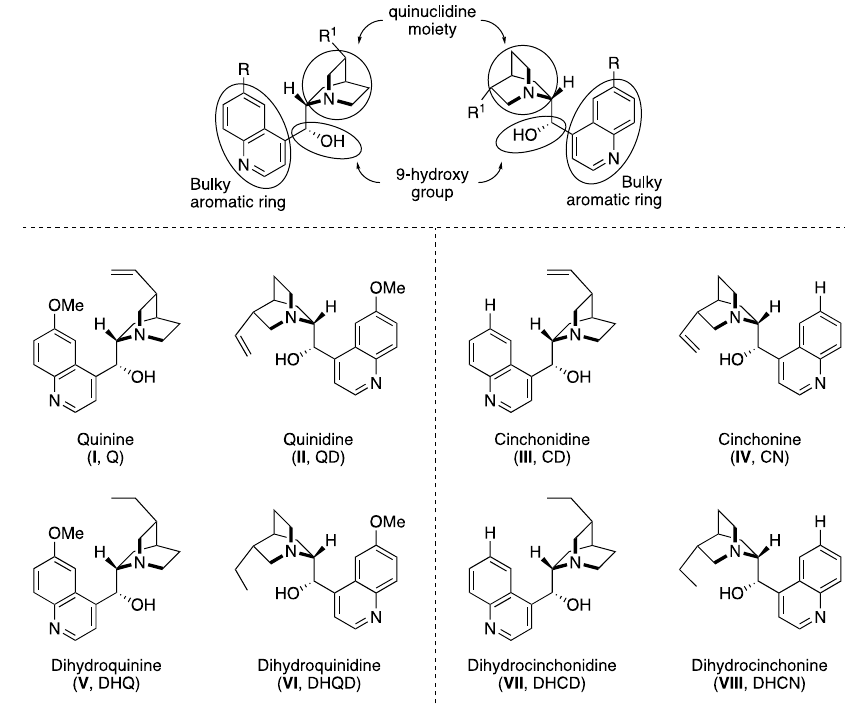
Figure 3. Representative examples of Cinchona alkaloids.